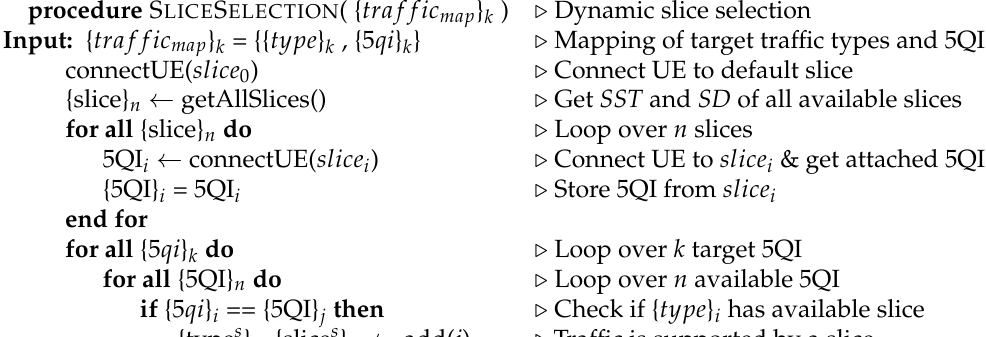
Algorithm 2 Algorithm for dynamic traffic redirection. procedure S LICE S ELECTION ( { tra f f ic map } k